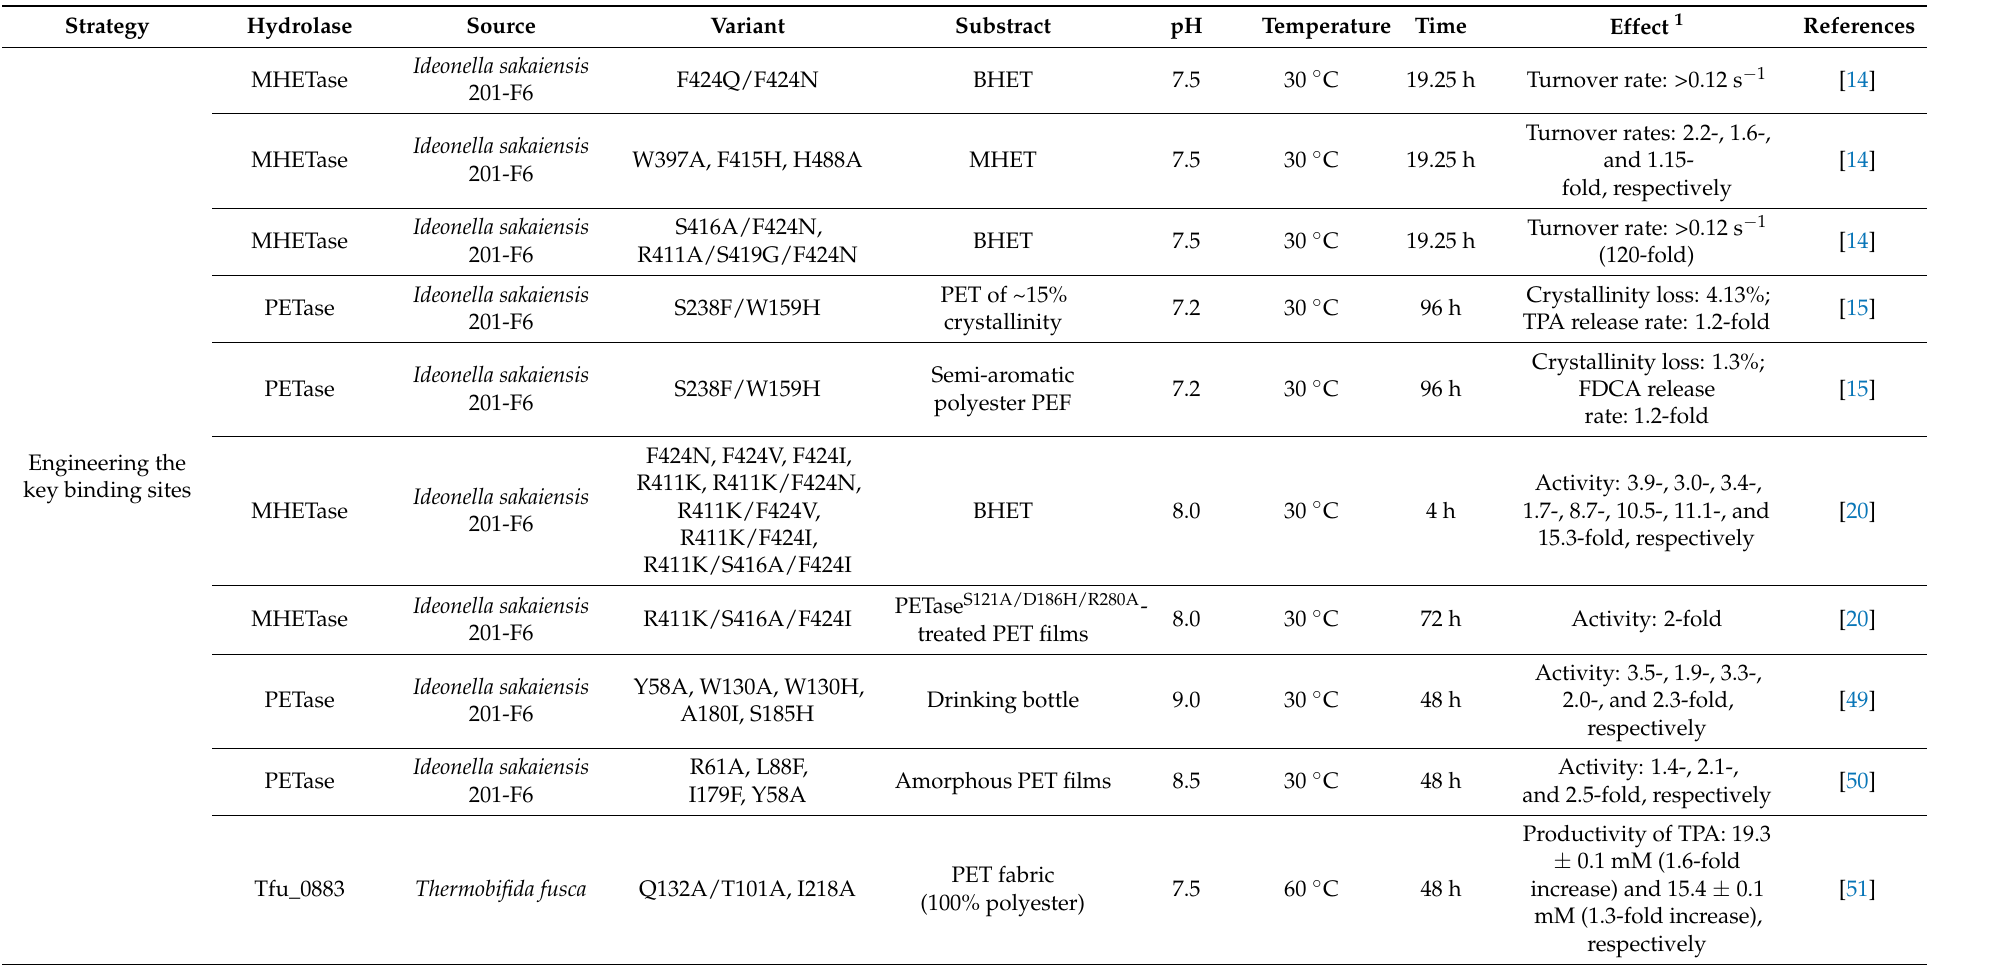
Table 1. Engineered hydrolases for PET